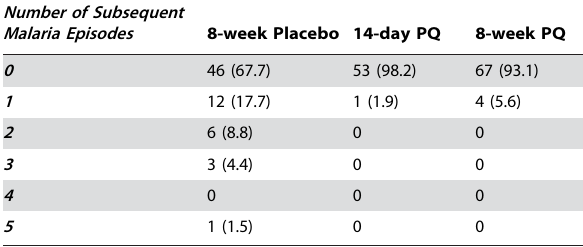
Table 4. Frequency of subsequent episodes of malaria in each treatment group over 11 month observation period, number (%).